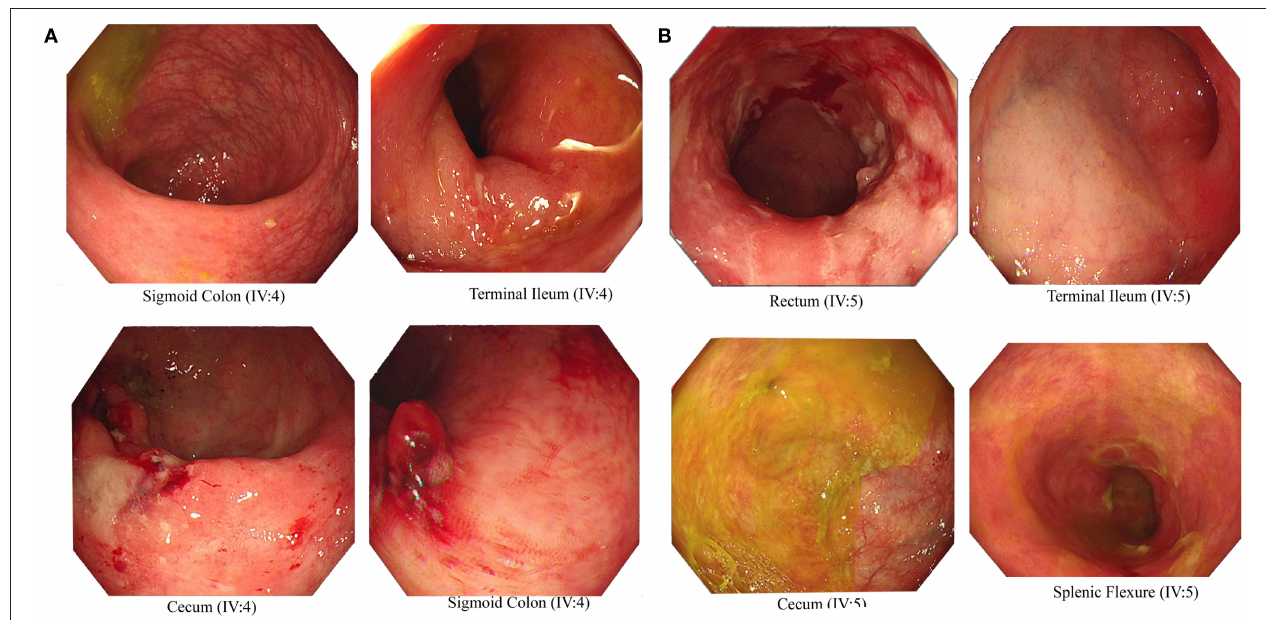
FIGURE 3 | Endoscopic images representing Crohn’s disease in the monozygotic twins. Inflammation and ulceration lesions (A) in sigmoid colon, terminal ileum, and cecum of IV-4 and (B) in rectum, terminal ileum, cecum, and splenic flexure of